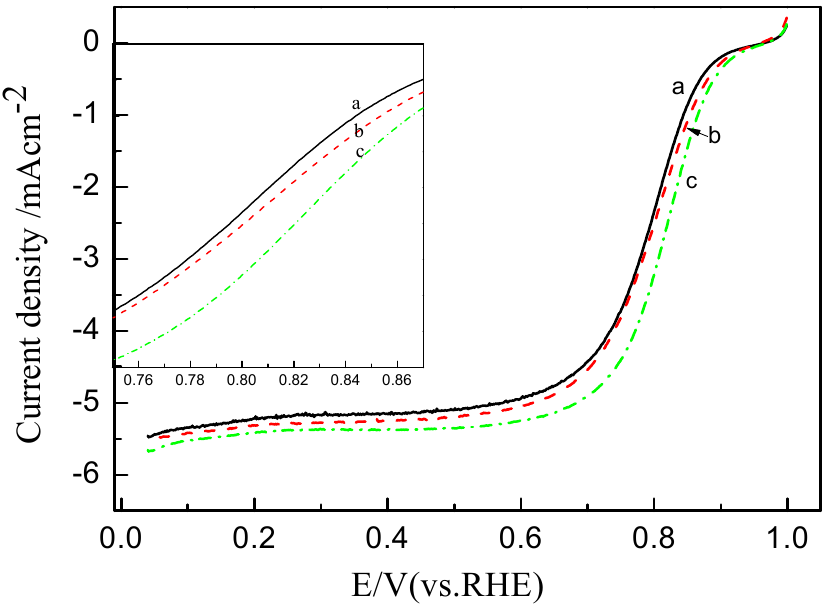
Figure 6. From the figure, the ORR on the catalyst is diffusion-controlled when the potential is less than 0.7 V and is under mixed diffusion kinetics control in the potential region between 0.7 and 0.85 V. For the sake of clarity, a close-up of this region is shown in the inset of Figure 6. For the pretreatment temperature used, the ORR activity of the Pt/C electrode increases in the order: 80 °C > 50 °C > 25 °C. At a given potential of 0.85 V, the current densities of Pt/C electrodes pretreated at ca. 25, 50, 80 °C are ca. 0.86, 1.09 and 1.45 mA cm − 1 , respectively, clearly indicating that the aggregation state of Nafion ionomer plays a significant role in the improvement of the ORR activity. Figure 6. Linear scan voltammograms (LSVs) of Pt/C catalytic electrodes with the catalyst ink pre-heated at ( a ) 25 °C; ( b ) 50 °C and ( c ) 80 °C in 0.1 M HClO4 saturated with pure O at a scan rate of 5 mV s − 1